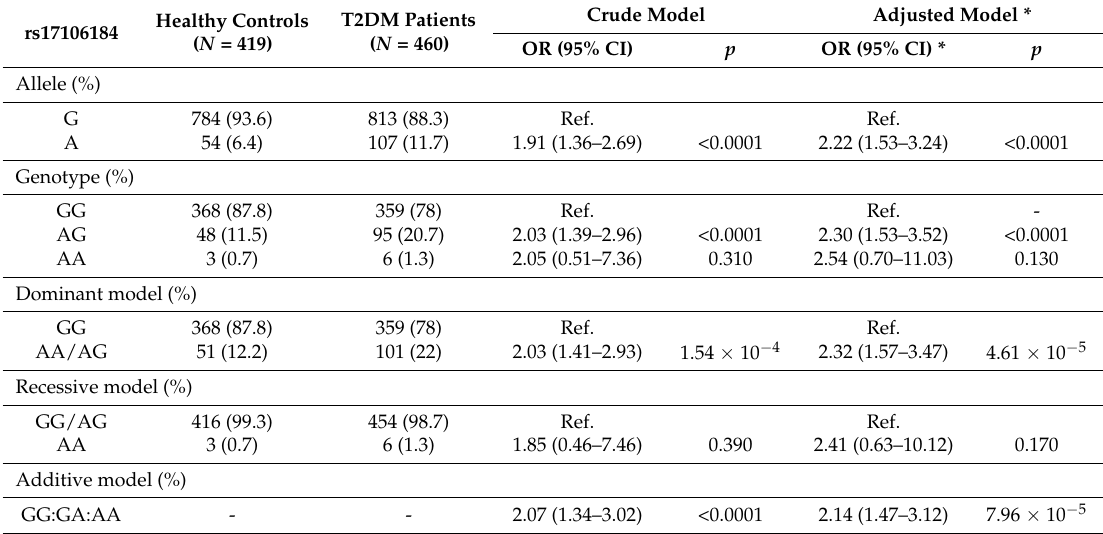
Table 3. Allelic and genotypic distributions of rs17106184 in the healthy controls and T2DM